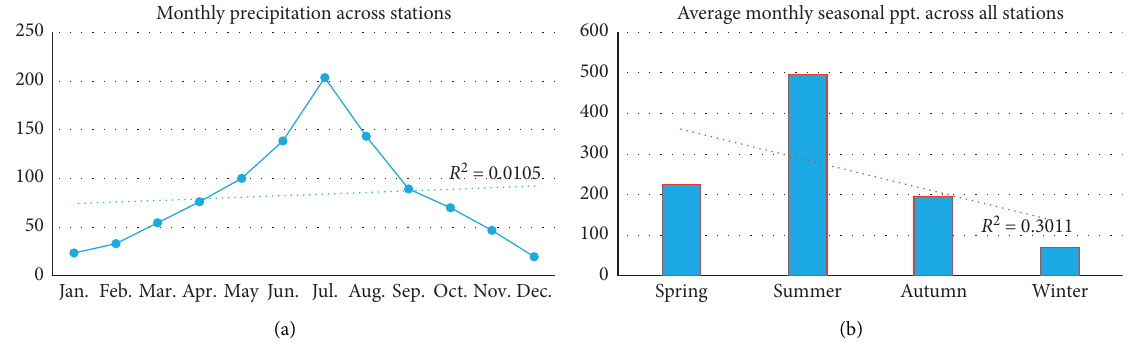
Figure 3: (a) Average monthly precipitation. (b) Average seasonal precipitation of the study area. Table 3: Z-statistic results of MK, ITA ( ф ), and Sen’s slope estimator test ( β ). Station’s